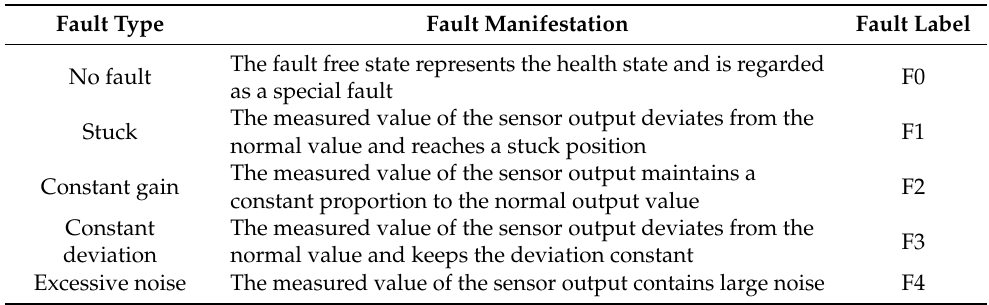
Table 1. Setting of fault